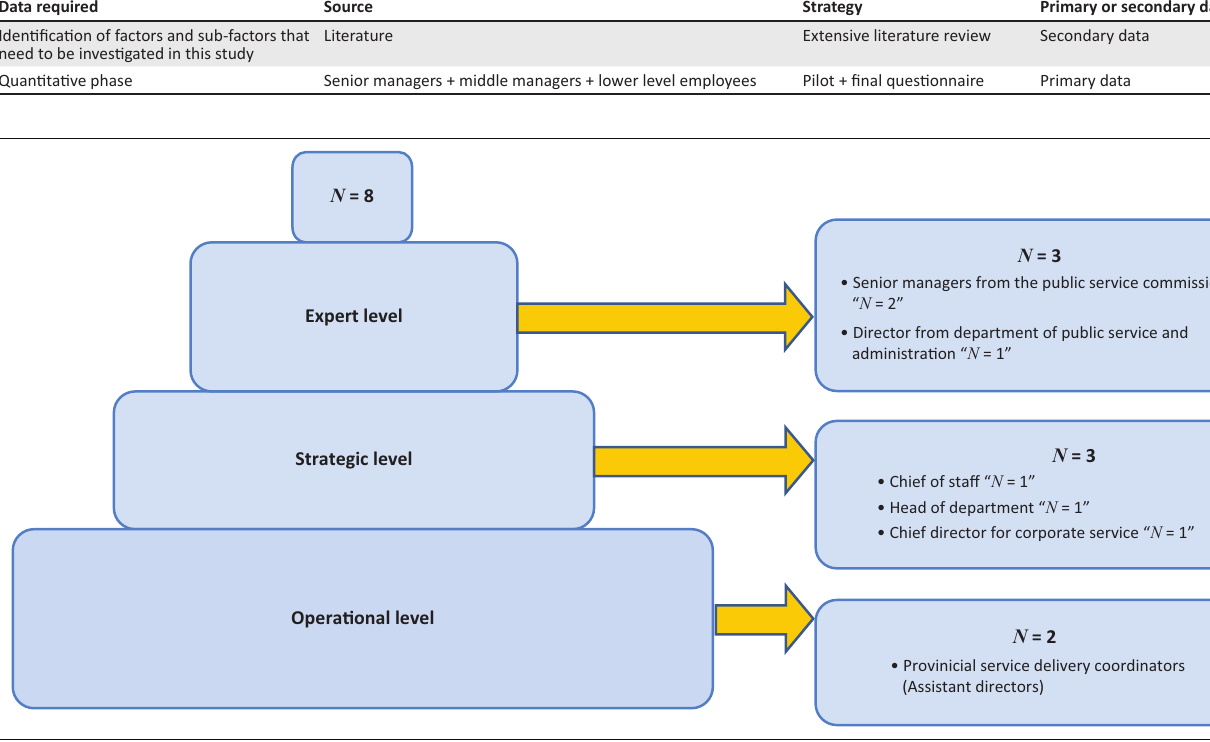
FIGURE 6: Sample size and levels of participants for the face-to-face interviews which were n = 8.